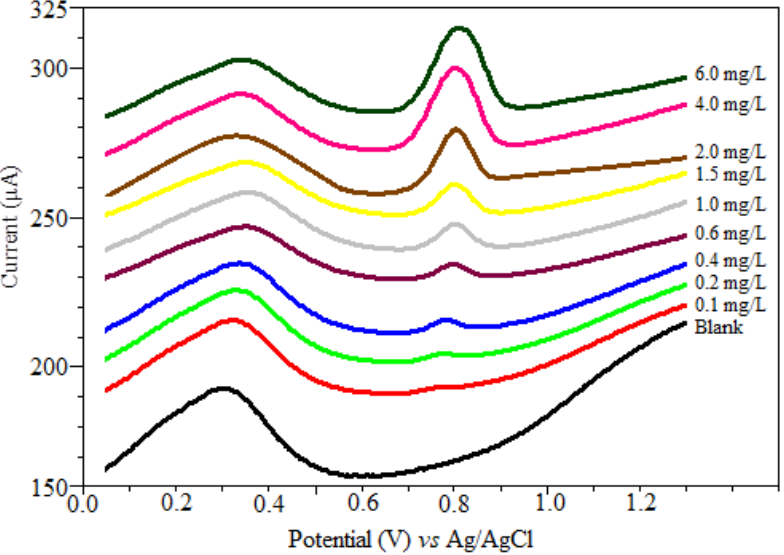
Figure 6. SWSV voltammograms for the calibration graph of oxyclozanide in BR buffer at pH 2.0. ( f = 80 Hz, t acc = 80 s, E acc = 0.0 mV, ΔE = 90 mV and ΔE s = 4 mV).